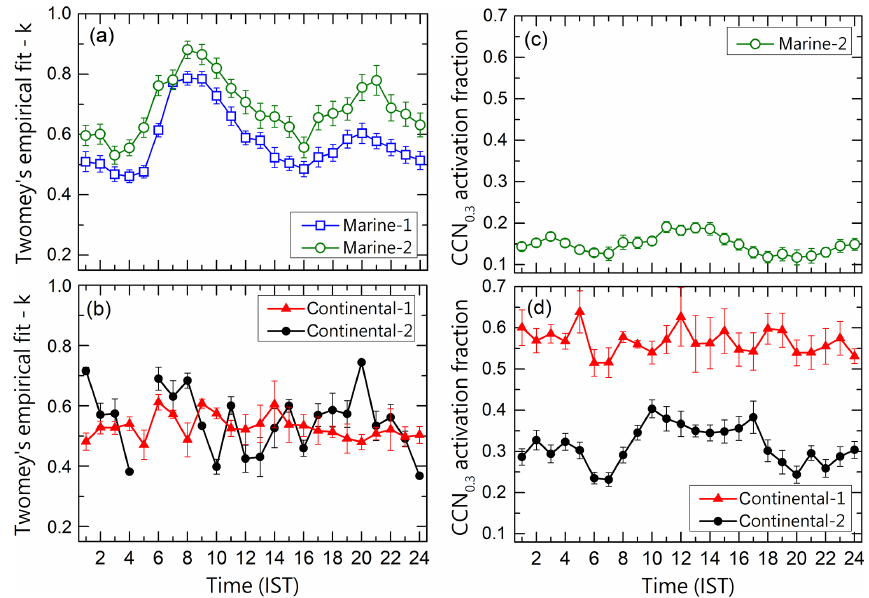
Figure 9. Diurnal variations of k values ( a and b ), and CCN activation fraction ( c and d ), during marine and continental conditions. Vertical bars indicate the standard error values.